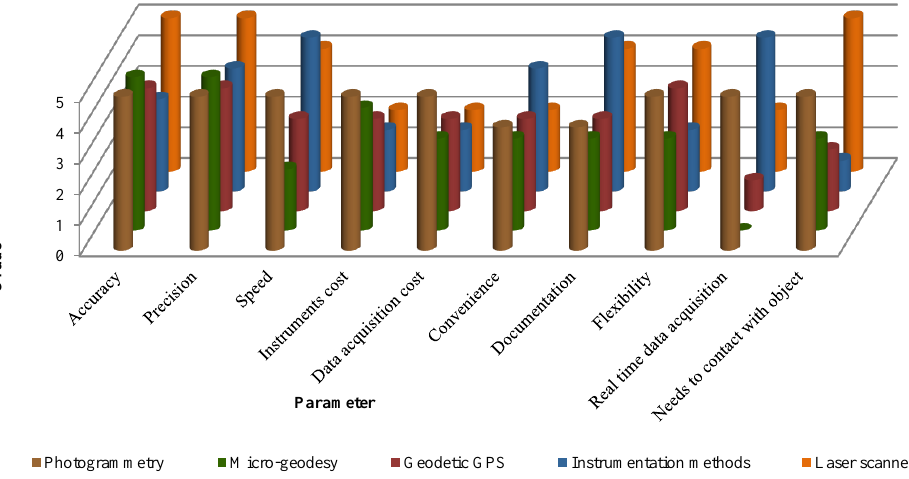
Figure 1. A qualitative comparison between close-range photogrammetric method and other methods in the measuring displacement of large-scale structures.